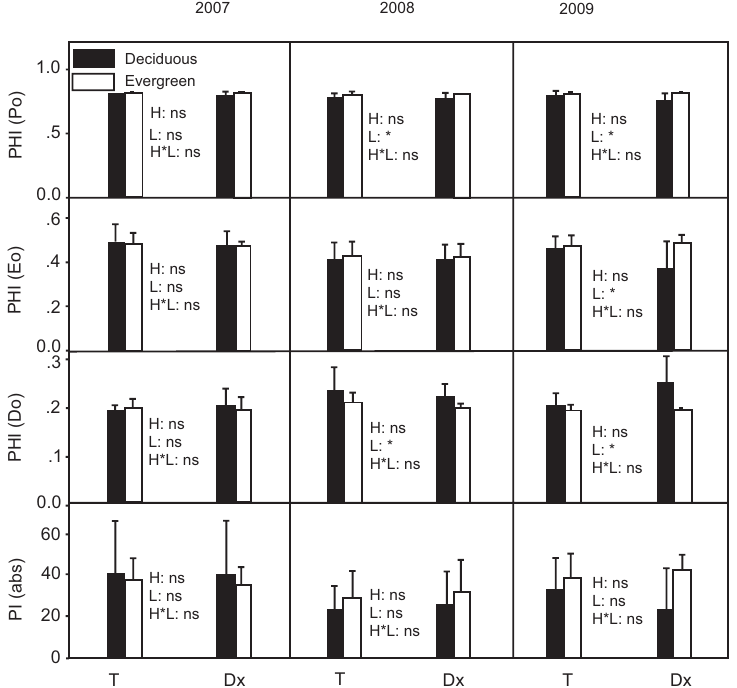
Figure 2. Photochemical characteristics. Effects of habitat (H), leaf phenology (L), and their interaction (H × L), on maximal PSII efficiency ( Φ (Po)), quantum yield of PSII electron transport ( Φ (Eo)), quantum yield of dissipation Φ (Do), and performance index (PI(abs)) (mean ± SD, n = 3–5) of the tree species in two habitats. See Figure 1 for other